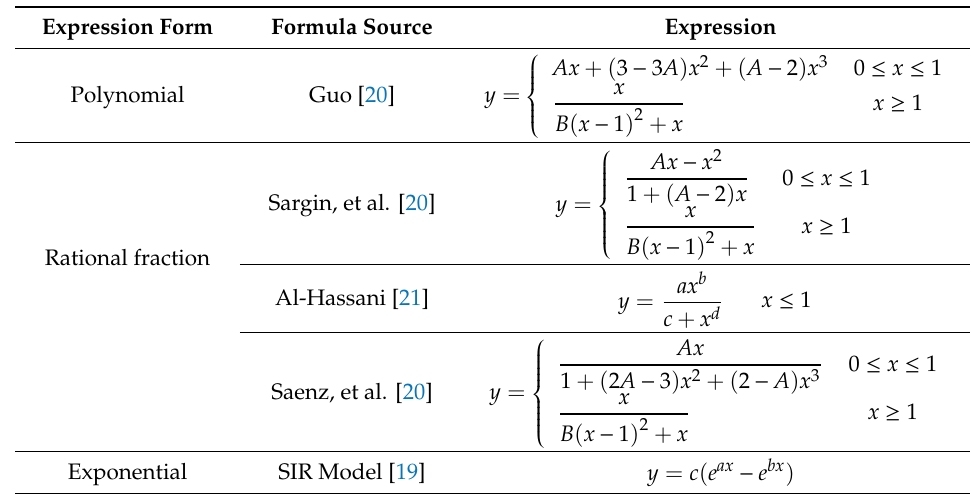
Table 4. Forms of uniaxial stress-strain